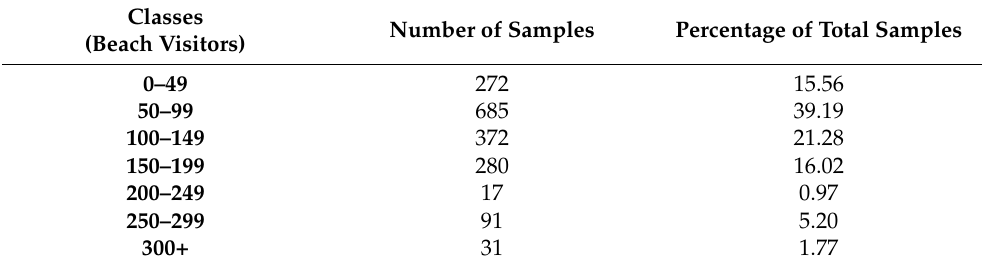
Table 1. Class distribution of beach visitors.